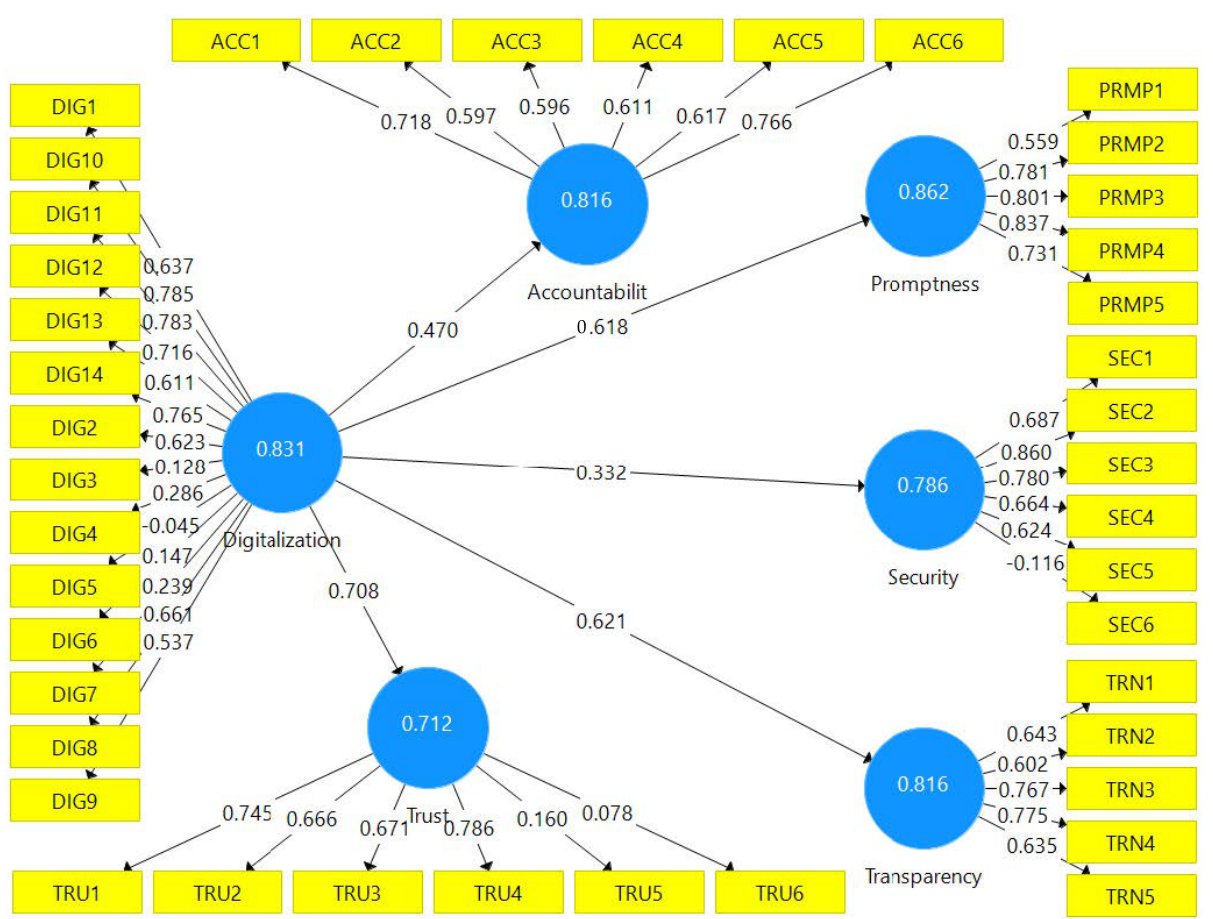
Figure 2. The Values of Composite Reliability. Note: DIG = Digitalization, ACC = Accountability, SEC = Security, TRU = Trust, TRN = Transparency, PRMP = Promptness.